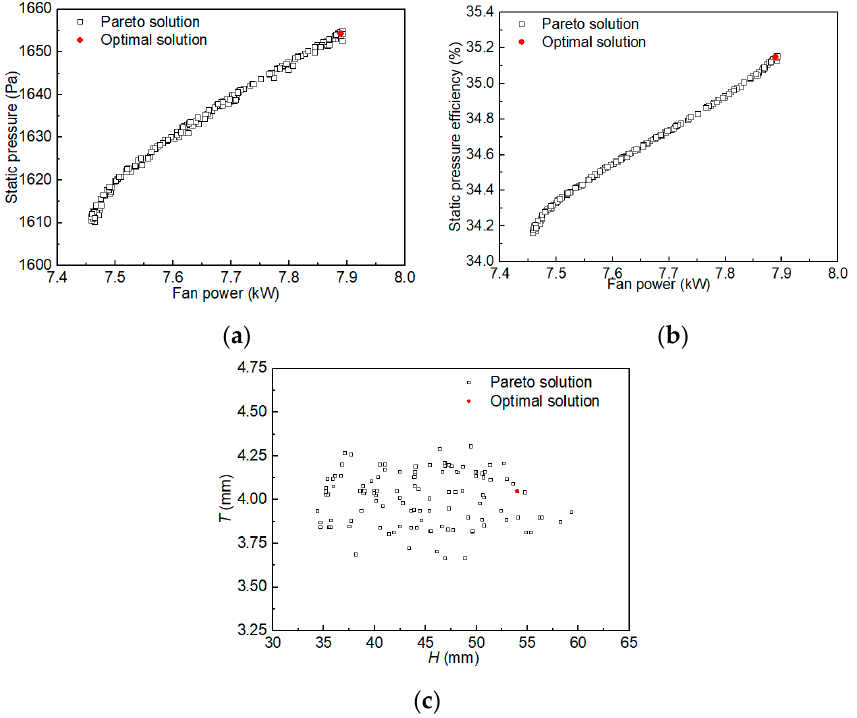
Figure 10. Pareto and optimal solutions of RSM: ( a ) power and static pressure; ( b ) power and static pressure e ffi ciency; ( c ) height and thickness.